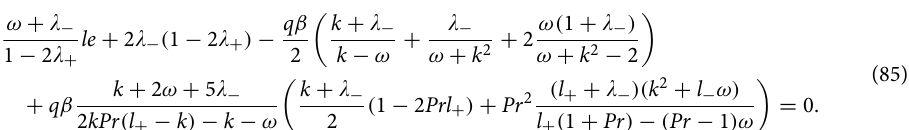
Figure 4. The same as Fig. 3 but for two values of Prandtl number, Pr